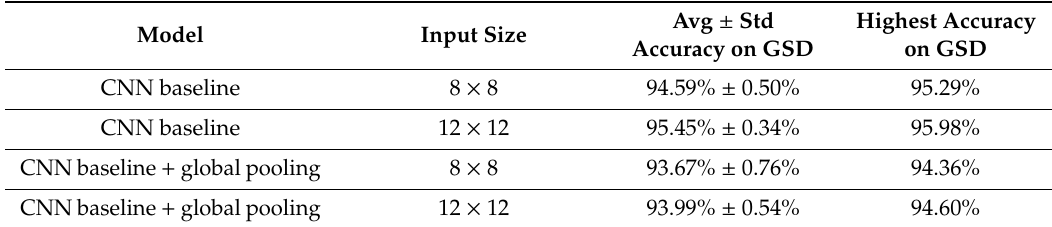
Table 2. Comparisons of structures trained on the data w / o spatial